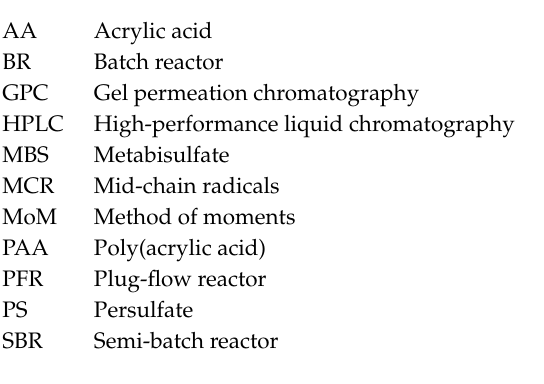
s1: Table S1: PAA standards used for the calibration of GPC. Peak molecular weight and polydispersity; Figures S1–S17: Tests SBR1-SBR17: weight-average degree of polymerization ( DP w ) and polydispersity (Ð) as a function of the monomer overall conversion; instantaneous conversion along the dimensionless axial coordinate; model results and experimental